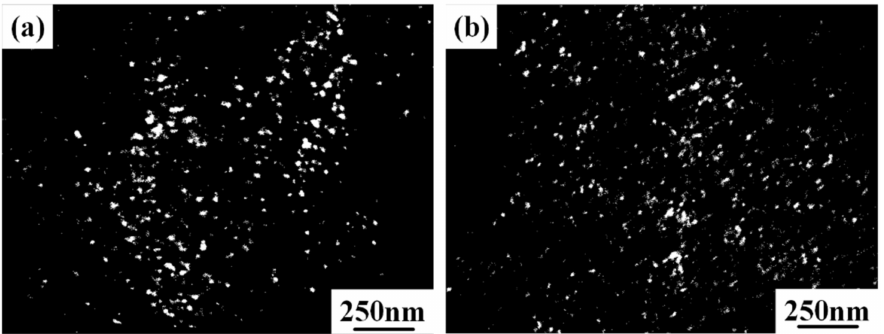
Figure 9. The dark-field TEM images revealing the fine ω particles in the Zr-4Hf-3Nb (wt%) alloy. All the bright spots are fine ω particles. ( a ) AC; ( b )